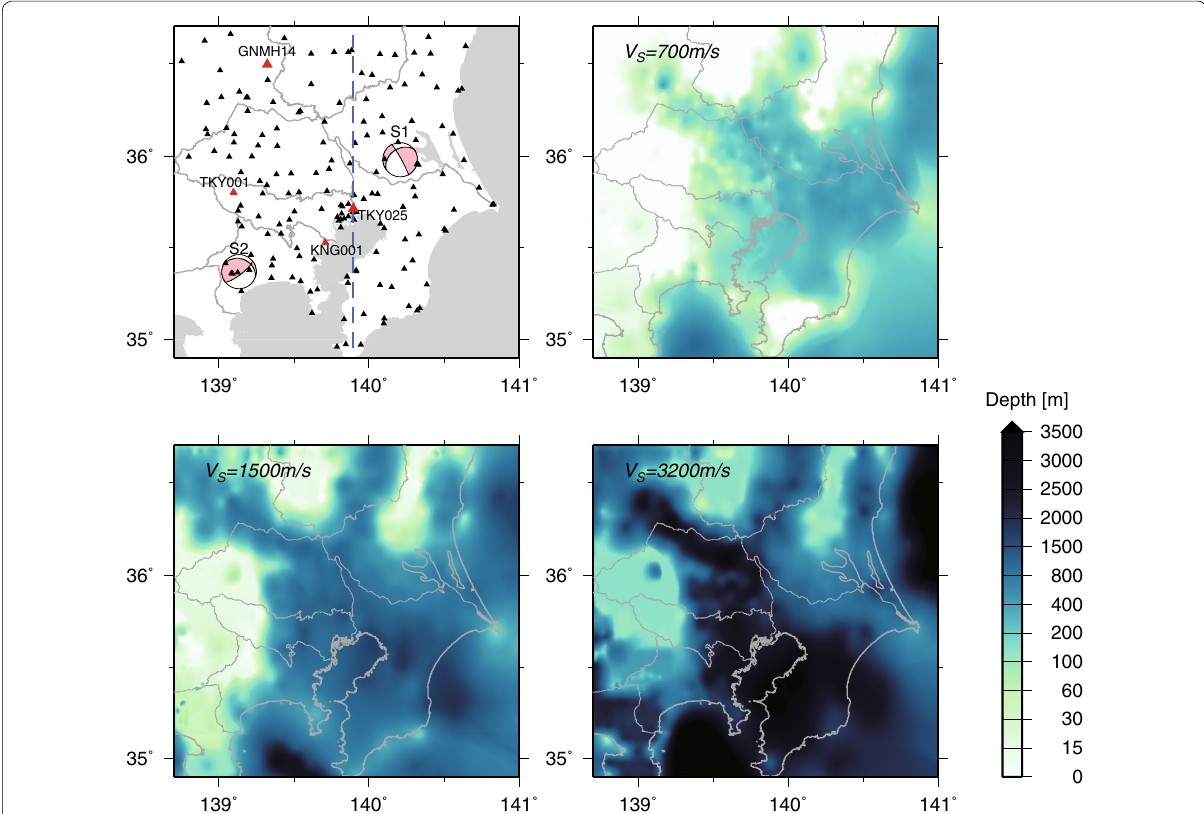
Fig. 1 Maps of the study area. K-NET and KiK-net stations (triangles) and epicenters of the source models S1 and S2 (top left panel). Dashed line denotes the north–south cross section of Fig. 2. Map of the velocity model showing the upper boundaries of selected layers (top right and bottom